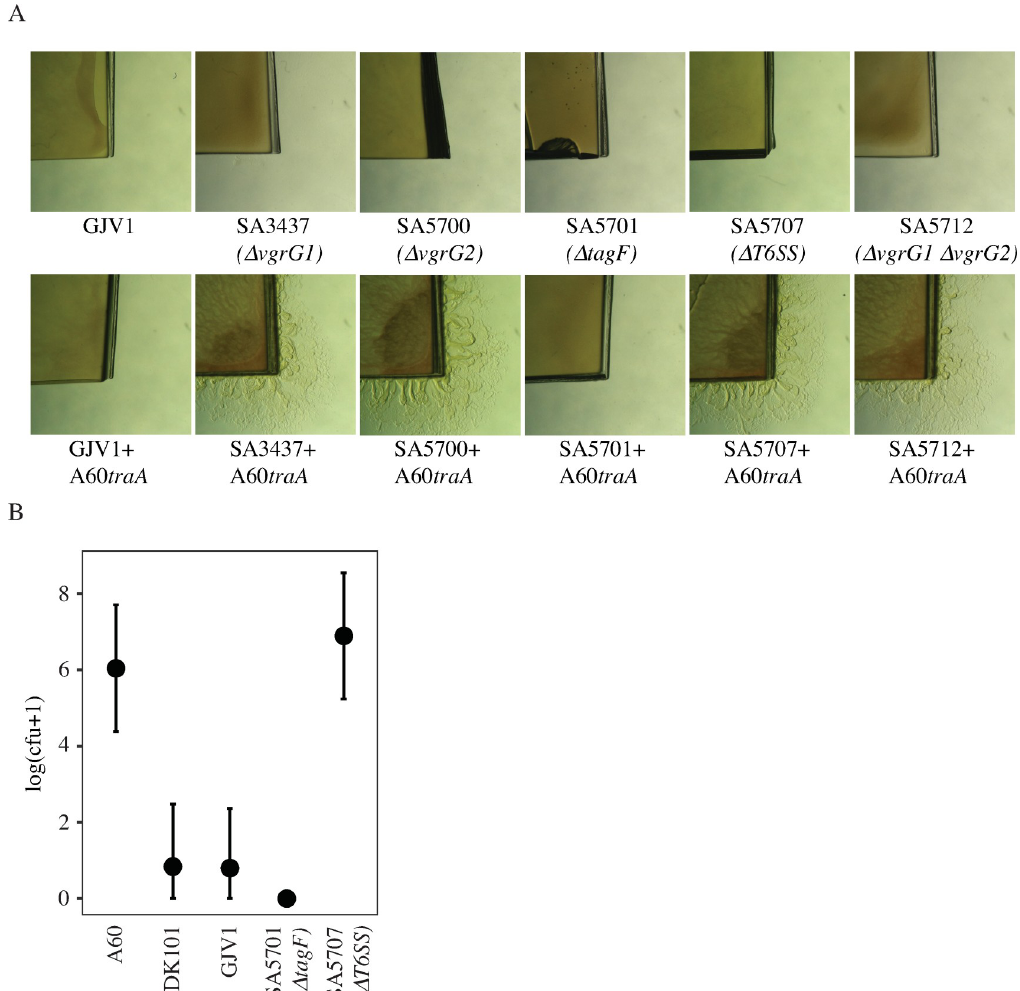
Fig 6. Deletion of T6SS genes alleviates TraA-independent killing of a natural isolate. A. Top row: Monocultures of kanamycin-sensitive GJV1 and T6SS mutants initially grown on CTT agar fail to grow when placed on CTT-kanamycin agar. Bottom row: Killing-assay phenotypes of cultures of A60 tra A mixed with GJV1 and several T6SS mutants initially grown on CTT agar and transferred to CTT-kanamycin agar. GJV1 and a Δ tagF mutant (SA5701) both retain T6SS activity [55] and kill A60 traA . Mutants known to have lost T6SS activity (SA3437, SA5700, SA5707, and SA5712 [55]) do not kill A60 traA . B. CFU counts of A60 traA after 24 hours of co-incubation with each strain indicated on the x axis. Error bars represent 95% confidence intervals, n = 3